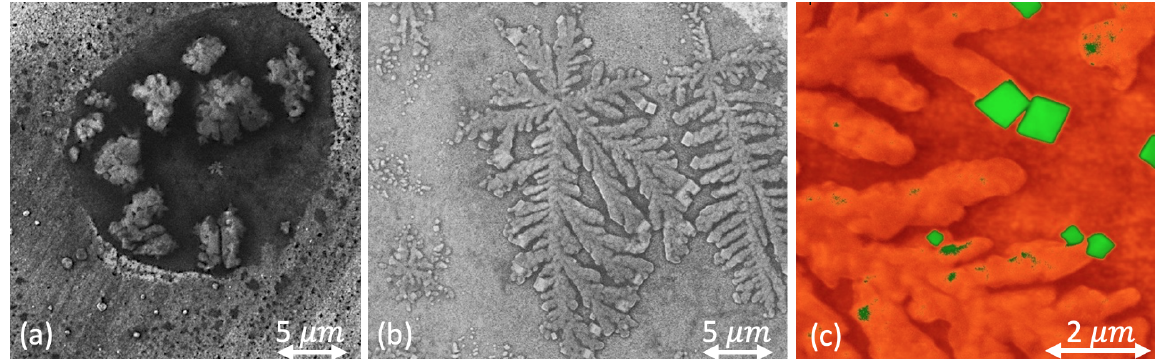
Figure 1. SEM images of cluster formation on an aluminum alloy surface under the effect of laser action: ( a ) a skeleton-type cluster, formed during local surface transformation at a pulse energy of 1 J; ( b ) a dendrite-type cluster, formed from a melted pool at a pulse energy of 5 J; the panel ( c ) combines the SEM-image and the results of an EDAX element analysis in order to make the B 4 C accumulation visible (B 4 C component marked by green while the alloy matrix is depicted with an orange color). One can see mostly cubic lattice formation of B 4 C at the ends of the